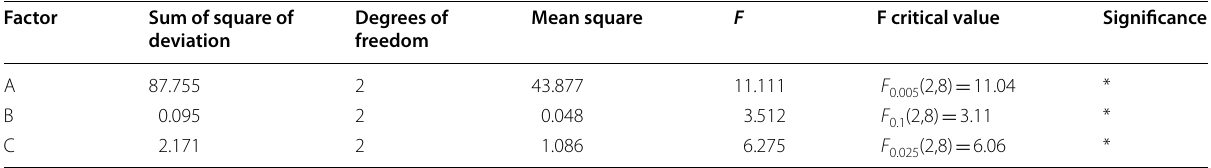
Table 15 ANOVA of the results of the 47 d compressive strength test